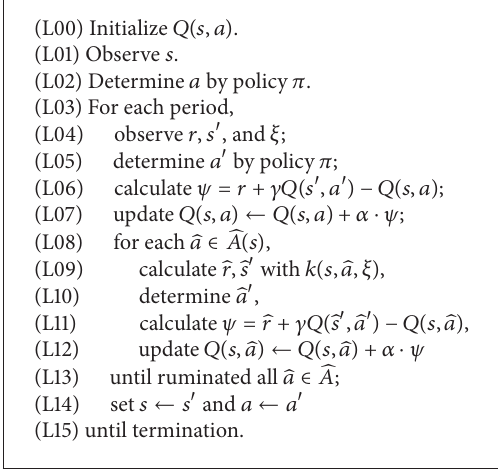
Algorithm 1: RSarsa